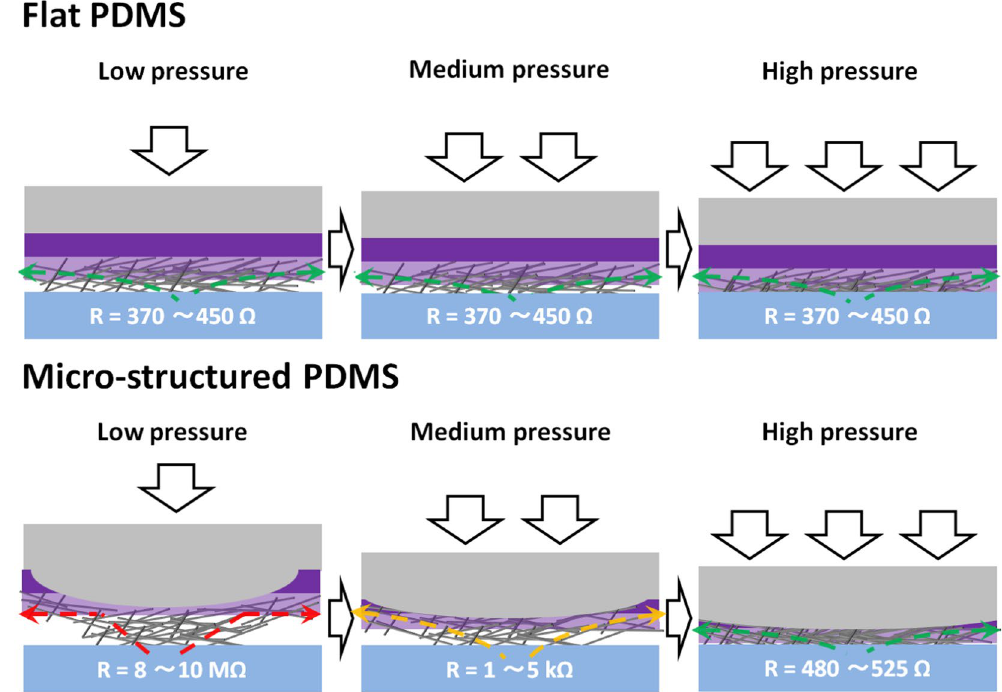
Figure 2. Schematic representation of the working mechanism and percolation paths in flat (top) and micro- structured (bottom) electrode pressure